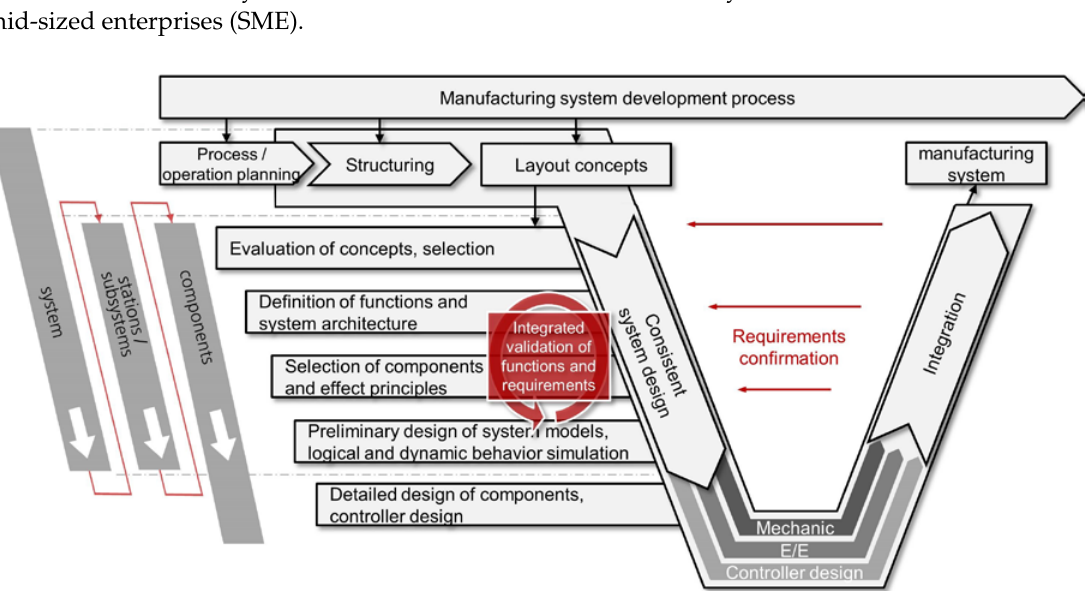
Figure 1. Adapted V-model for manufacturing system design.